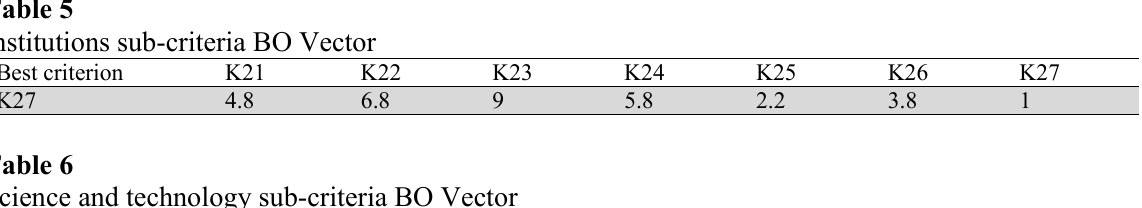
Science and technology sub-criteria BO Vector Best criterion